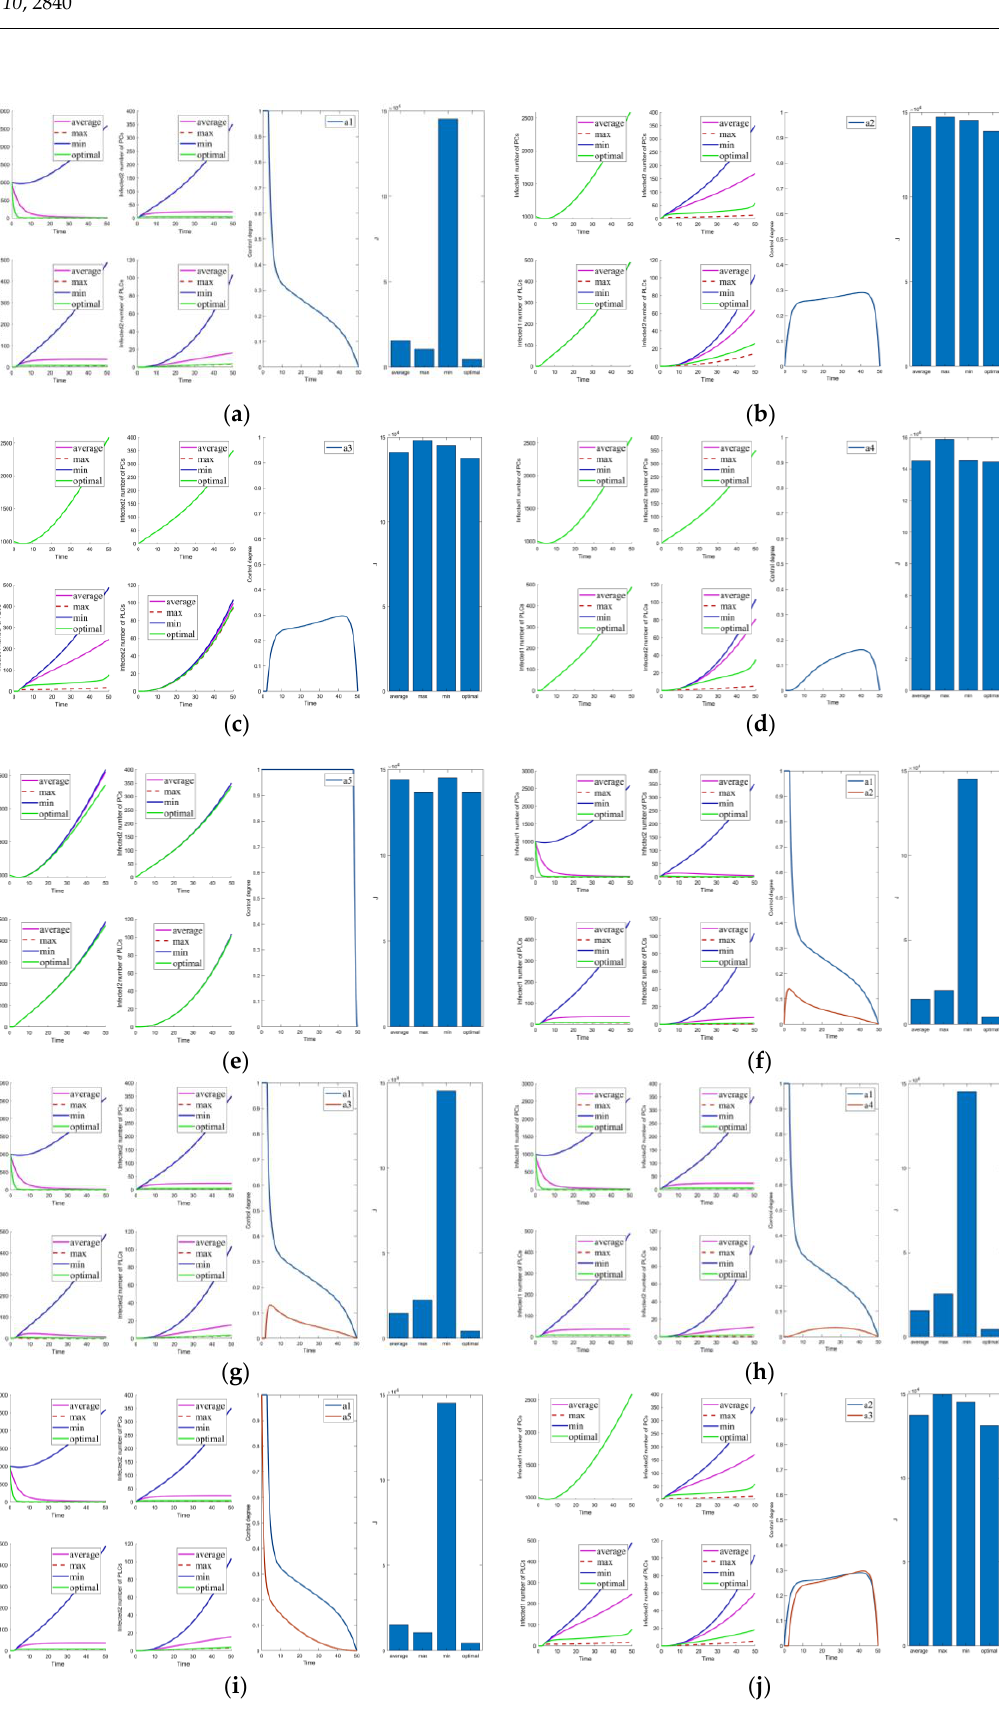
Figure 8. Solutions of the optimal control strategies for Cases 1 – 10 (removing average constant). ( a ) Case 1; ( b ) Case 2; ( c ) Case 3; ( d ) Case 4; ( e ) Case 5; ( f ) Case 6; ( g ) Case 7; ( h ) Case 8; ( i ) Case 9; ( j ) Case 10.